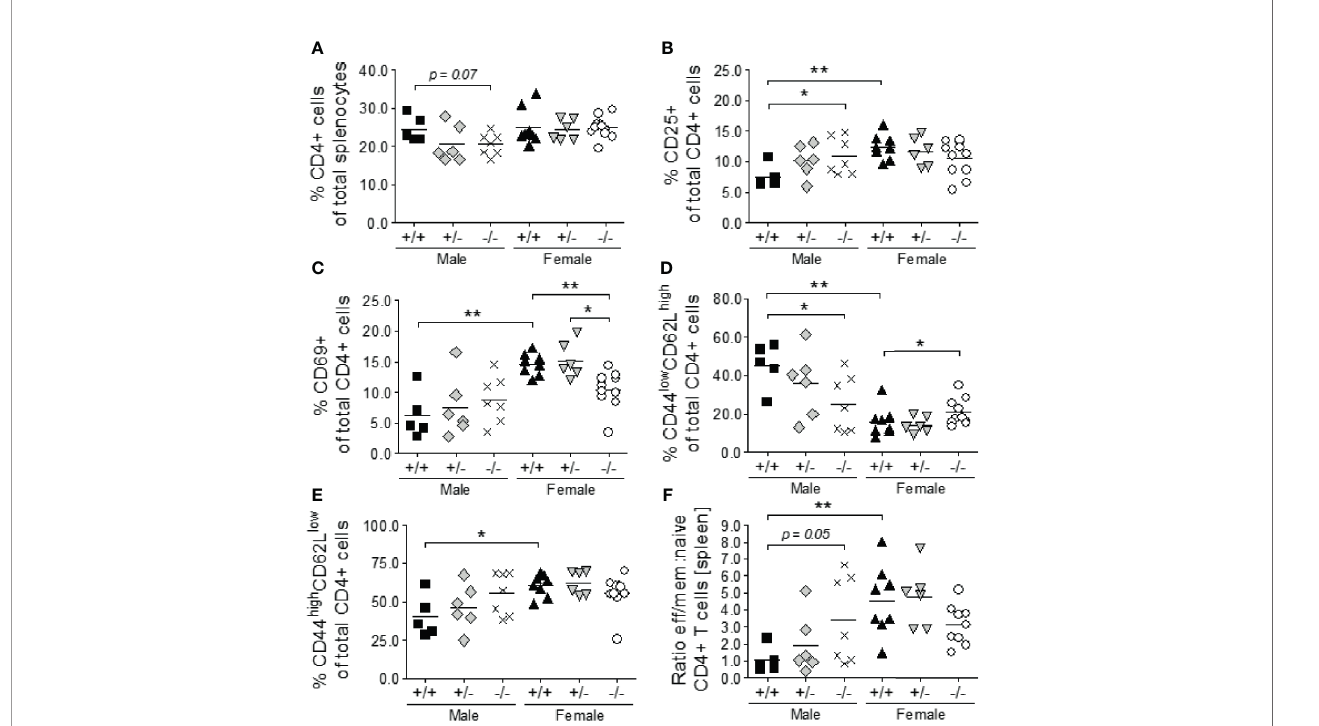
FIGURE 5 | S100a9- de fi ciency promotes the activation and differentiation of CD4+ T naïve cells to effector memory cells in S100a9 -/ - male BWF1 mice. Spleens were harvested from eight month old BWF1 lupus-prone mice and percentages of T lymphocytes and their subsets were determined by fl ow cytometry: total CD4 + cells (A) , CD25 + CD4 + cells (B) , CD69 + CD4 + cells (C) , naïve (CD44 low CD62L high ) CD4 + cells (D) , effector memory (CD44 high CD62L low ) CD4 + cells (E) , and the ratio between naïve and effector memory cells (F) . Each symbol represents one individual mouse. *p < 0.05; **p < 0.01, Student ’ s unpaired t test with Welch ’ s correction. One-way ANOVA: p < 0.05 (A) , p < 0.05 (B) , p < 0.0001 (C) , < 0.0001 (D) , p < 0.05 (E) , p < 0.01 (F)